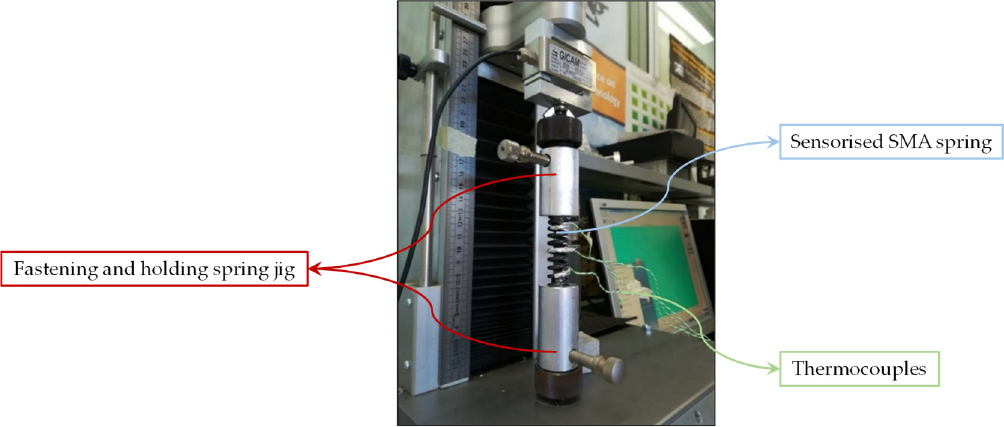
Figure 9. Sensorized SMA spring with thermocouples for the heated tensile test.